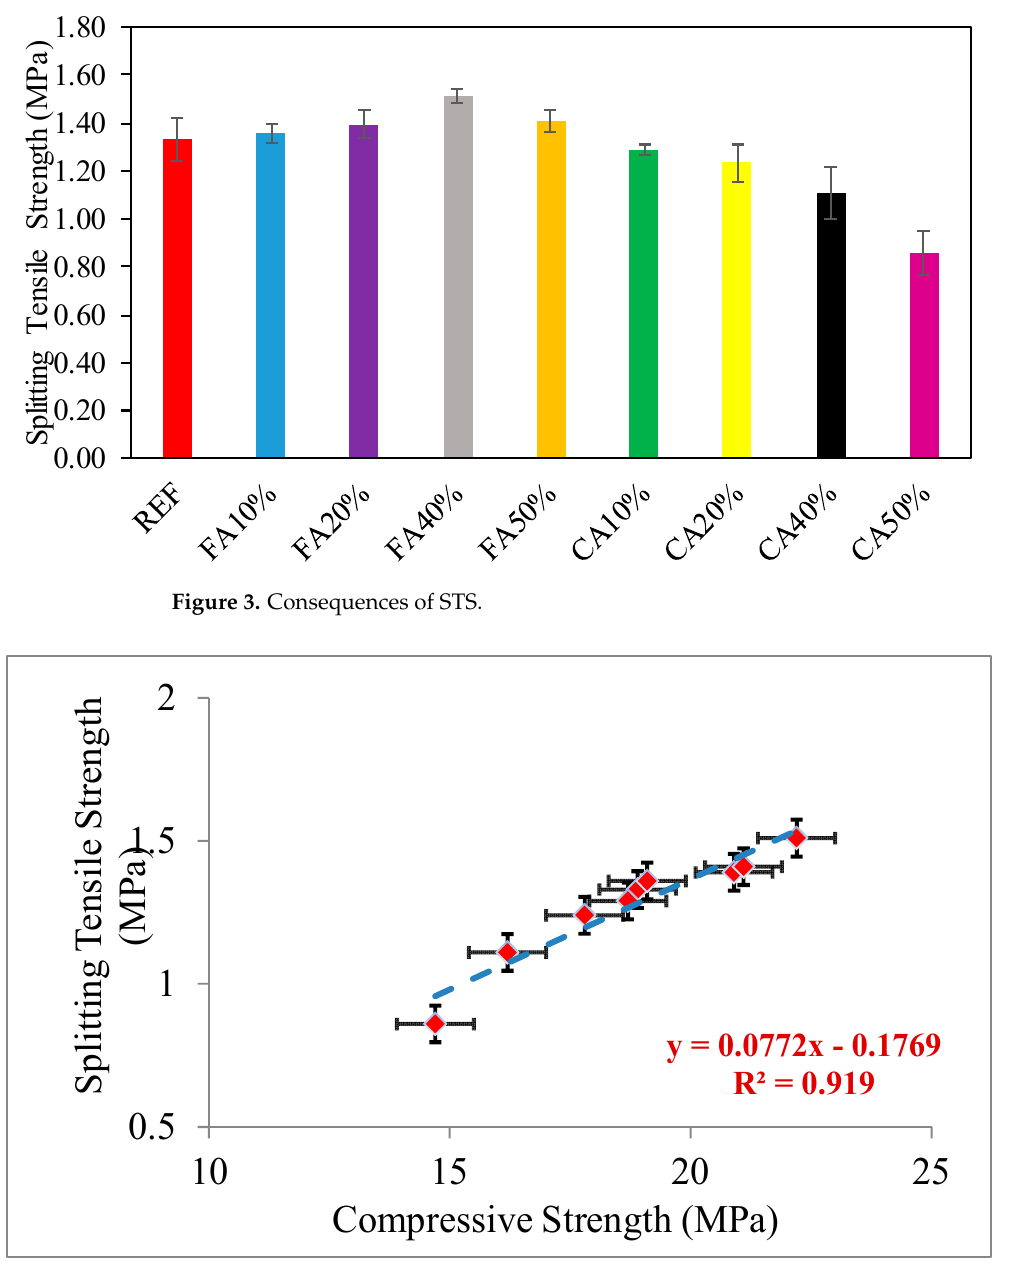
Figure 4. Splitting tensile strength variation versus compressive strength.